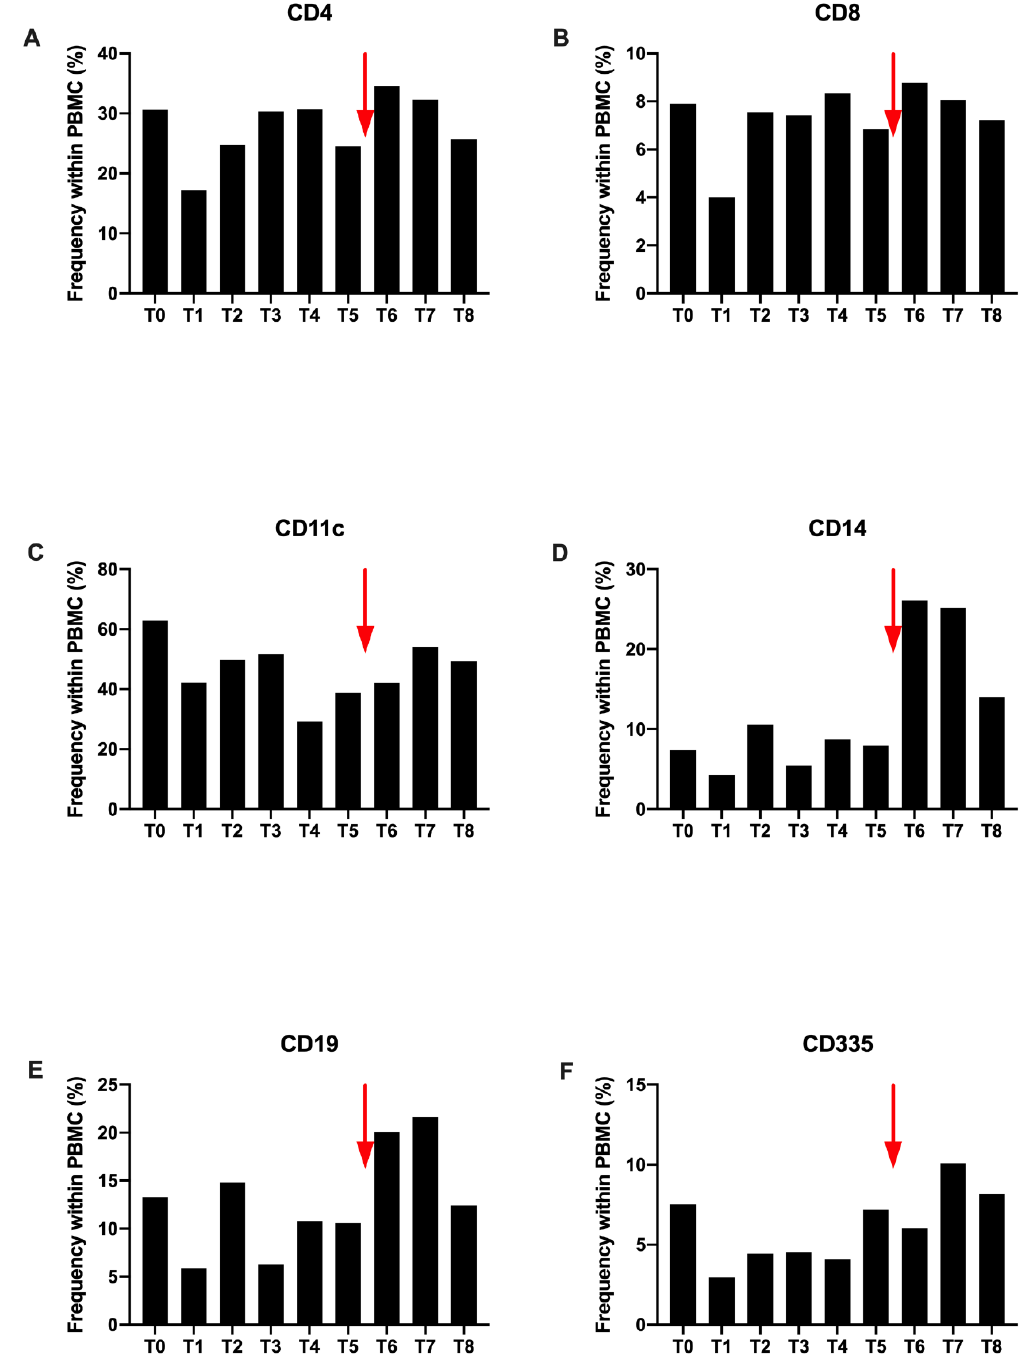
Figure 2. Expression of CD4 + ( A ), CD8 + ( B ), CD11c + ( C ), CD14 + ( D ), CD19 + ( E ) and CD335 + ( F ) markers among the patient’s peripheral blood mononuclear cells. All these results were obtained from flow cytometry assay and expression percentage. The red arrow corresponds to the single injection of Nivolumab. T0 to T8 correspond to all the study time points as described above from before the radiotherapy to 1 year after the last session.